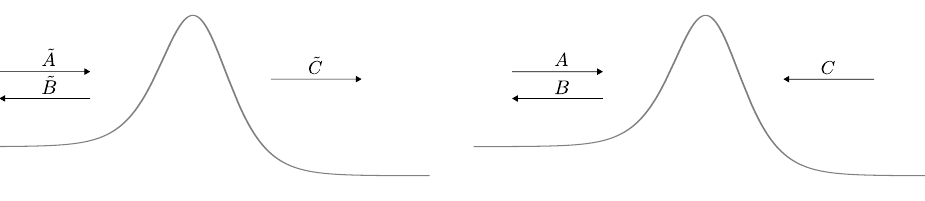
Figure 2 . The naive (left) and physical (right) setup of